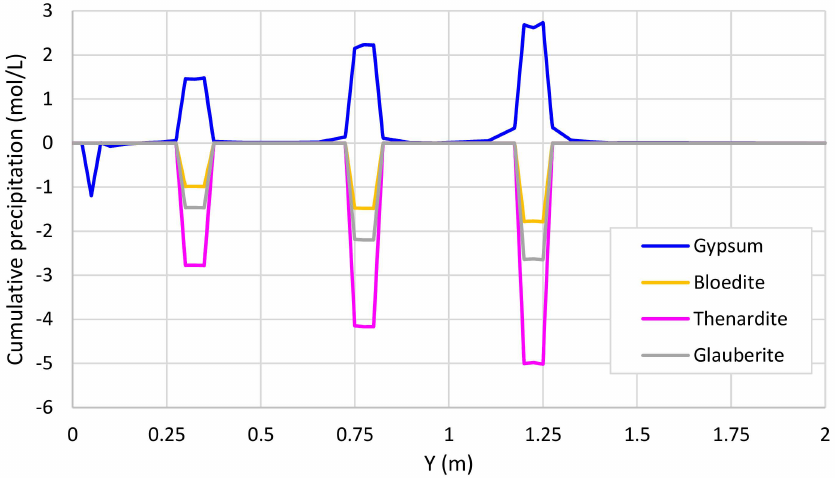
Figure 9. Spatial distribution of the cumulative gypsum, bloedite, thenardite, and glauberite dissolu- tion/precipitation computed along a vertical line at x = 1 m after 2 years of simulation (positive for precipitation and negative for